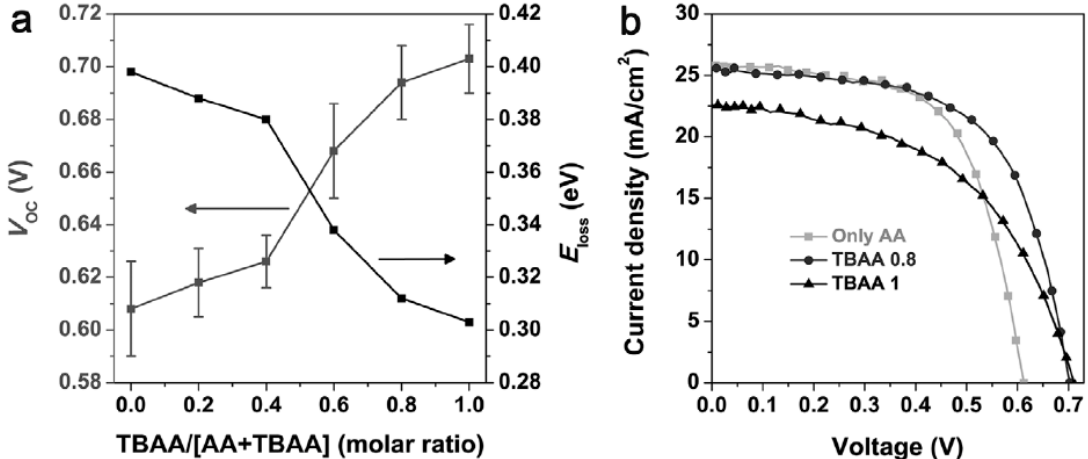
Figure 7. Photovoltaic performance depending on ratio of used ligand species (ammonium acetate (AA) and tetrabutylammonium acetate (TBAA)) in solution-phase ligand exchange. ( a ) Trends of V OC and E loss observed in PbS CQD photovoltaics according to ligand ratio. ( b ) J–V curves of PbS CQD PVs with various ligand blend ratios. Reprinted from reference [50]. Copyright 2017 Advanced Materials.